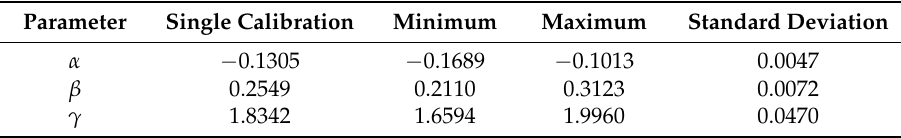
Table 2. Calibration parameters of the single calibration model as well as the statistics from all 701 sensor calibrations.